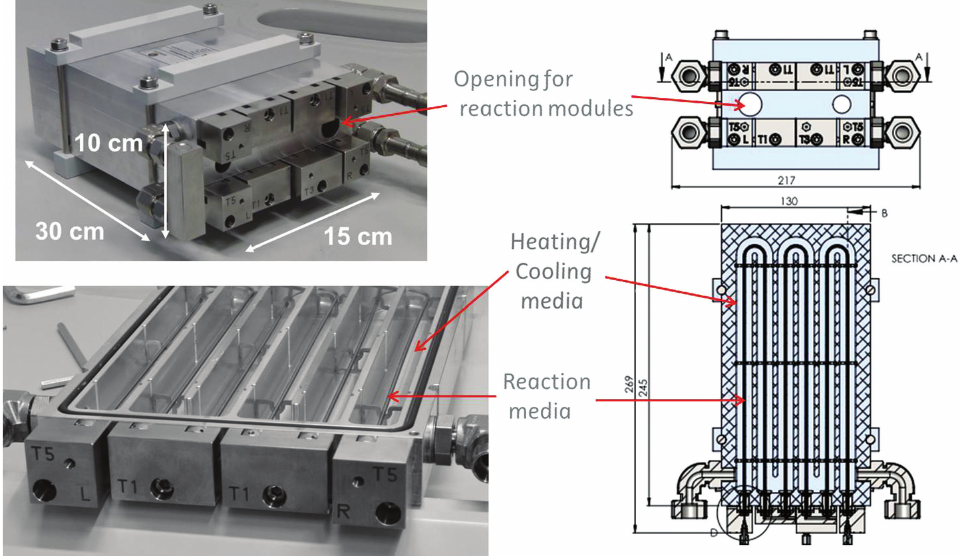
Figure 2 Pictures and scheme of the plug & play